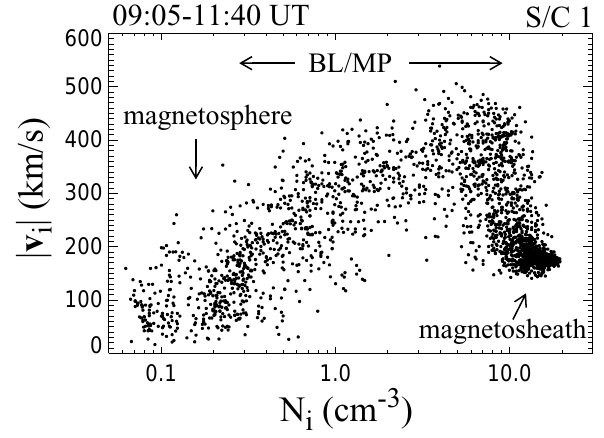
Fig. 4. Scatter plot of spacecraft 1 ion flow speed as a function of ion number density for the entire 2.5-h pass. The flows in the Figure 4. Scatter plot of Spacecraft 1 ion flow speed as a MP/outer BL are enhanced relative to magnetosheath flows, with function of ion number density for the entire 2.5-hour pass. no The flows in the MP/outer BL are enhanced relative to magnetosheath flows, with no exceptions.